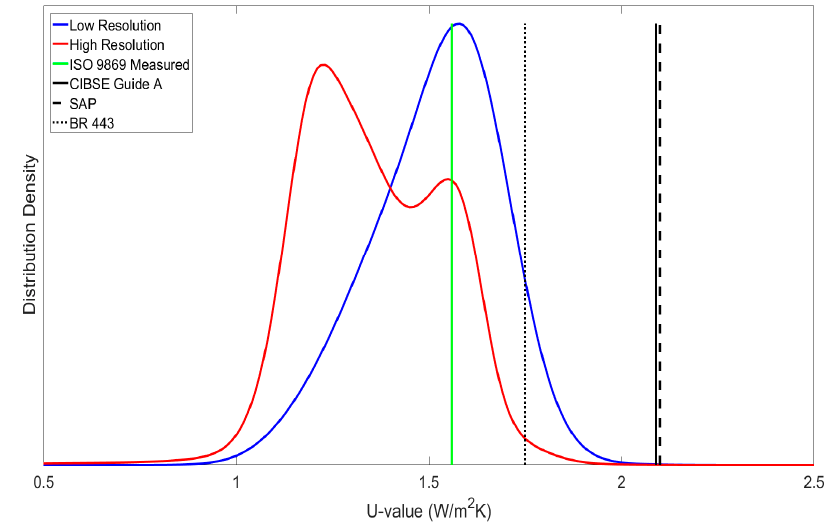
Figure 9. Epanechnikov Kernel distribution density of U-values from IRT for the master bedroom external wall, compared to a point measurement and standardised values.